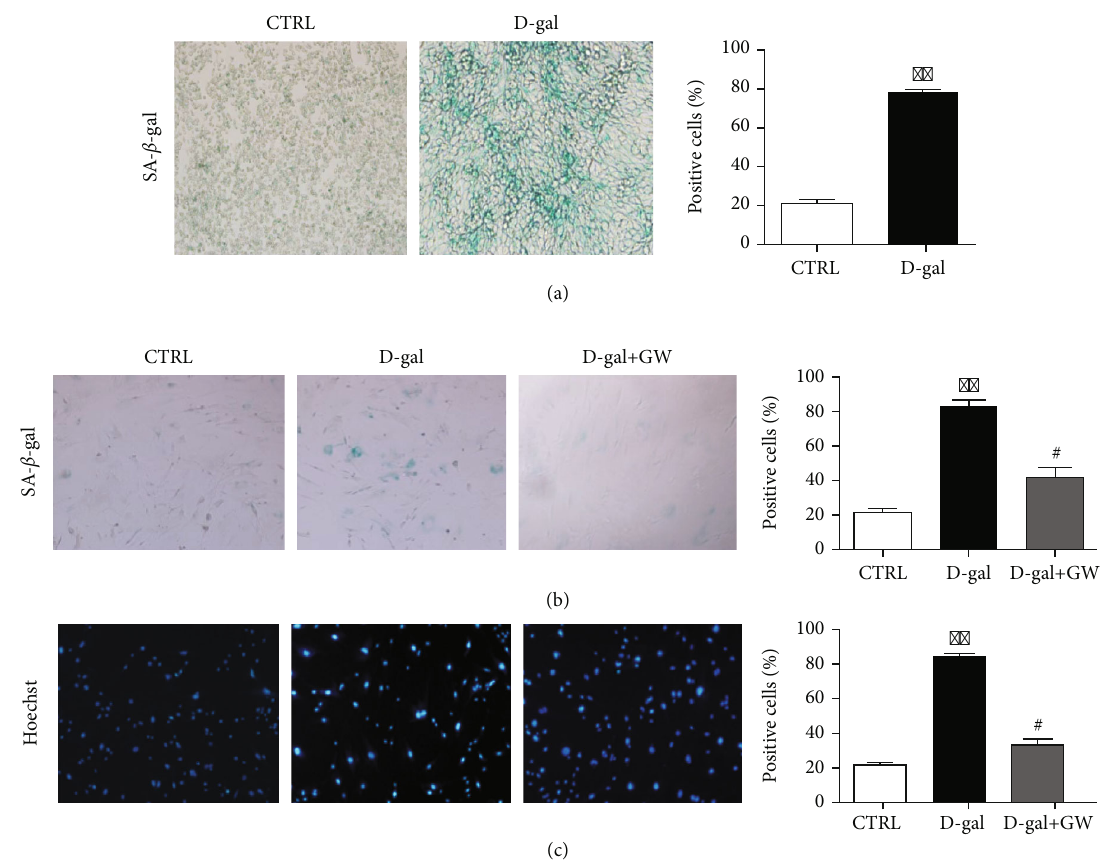
Figure 1: Senescence endothelial cells promoted skin fi broblasts senescence via extracellular vesicles pathway. (a)SA- β -gal staining analyze of D-gal-induced senescence endothelial cells. (b) SA- β -gal staining assay of skin fi broblasts cocultured with endothelial cells treated by PBS, D-gal, and D-gal + GW4869. (c) Hoechst 33258 staining assay of skin fi broblasts cocultured with endothelial cells treated by PBS, D-gal, and D-gal + GW4869. ∗∗ p < 0 : 01 vs. CTRL; # p < 0 : 05 vs. D-gal;. CTRL: control; D-gal: D-galactose; GW: (Figure 1(a)). To estimate the e ff ect of senescence endothe- lial cells on fi broblasts via extracellular vesicles pathway, the skin fi broblasts were cocultured with control endothe- lial cells, D-gal-induced senescence endothelial cells, and D-gal-induced senescence endothelial cells with GW4869, respectively. GW4869 is an inhibitor of extracellular vesicles biogenesis/release. We found that the numbers of senescence and apoptosis positive cells in skin fi broblasts were signi fi - cantly increased after cocultured with senescence endothelial cells. On the contrary, the numbers of senescence and apoptosis-positive cells in skin fi broblast cells cocultured with senescence endothelial cells were signi fi cantly decreased after treatment with GW4869. (Figures 1(b) and 1(c)).